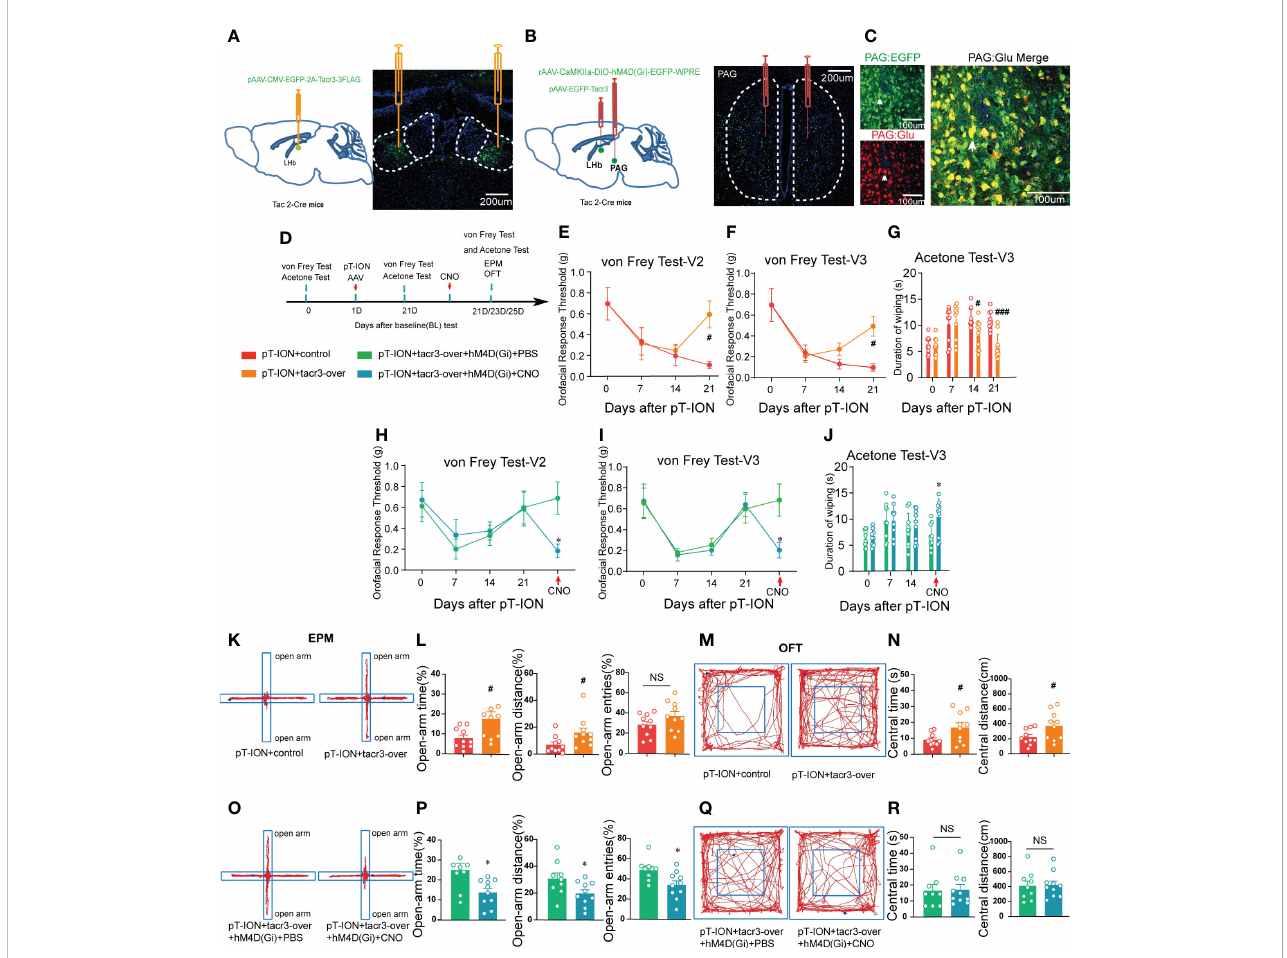
FIGURE 10 Inhibition of the release of NKB in the fPAG reversed the alleviating effect of Tacr3 overexpression in the LHb on pT-ION-induced orofacial allodynia and pain-associated anxiety-like behaviors. (A) Schematic (left) and representative image (right) of the injection of pAAV-CMV-EGFP-2A-Tacr3-3FLAG into the LHb of Tac2-Cre mice. (B) Schematic of the injection of pAAV-CMV-EGFP-2A-Tacr3-3FLAG into the LHb and injection of rAAV-CaMKIIa-DIO-hM4D (Gi)-EGFP-WPRE-hGH into the fPAG of Tac2-Cre mice (left). Typical image of rAAV-CaMKIIa-DIO-hM4D(Gi)-EGFP-WPRE-hGH injection into the fPAG of Tac2-Cre mice (right). Green, EGFP; Blue, DAPI. (C) Images showing that GFP-labeled neurons within the fPAG co-localized with glutamate. (D) The time schedule of behavioral testing, pT-ION operation, virus injection, and CNO administration. (E-G) pT-ION – induced V2 allodynia (E) , V3 allodynia (F) , and V3 cold allodynia (G) were improved by bilateral pAAV-EGFP-Tacr3 injection into the LHb (#p < 0.05, ###p < 0.001 vs. the pT-ION+vehicle group, n = 10 mice per group). However, the improvements in primary mechanical allodynia (H) , secondary mechanical allodynia (I) , and secondary cold allodynia (J) were reversed by bilateral rAAV-CaMKIIa-DIO-hM4D(Gi)-EGFP injection into the fPAG after CNO administration. (*p < 0.05 vs. the pT-ION+tacr3-over +hM4D(Gi)+PBS group, n = 10 mice per group). (K, O) Typical trajectories in the EPM. (L) The percentages of open-arm time and distance after pT-ION were increased by bilateral pAAV-EGFP-Tacr3 injection into the LHb, while the percentage of open-arm entries remained unchanged (#p < 0.05 vs. the pT-ION+vehicle group, n = 10 mice per group). (P) The increased percentages of open-arm time, distance, and entries was reversed by bilateral rAAV- CaMKIIa-DIO-hM4D(Gi)-EGFP injection into the fPAG after CNO administration (*p < 0.05 vs. the pT-ION+tacr3-over+hM4D(Gi)+PBS group, n = 10 mice per group). (M, Q) Typical trajectories in the OFT. (N) The central distance and central time were increased by bilateral pAAV-EGFP-Tacr3 injection into the LHb (#p < 0.05 vs. the pT-ION+vehicle group, n = 10 mice per group). (R) The central distance and central time remained unchanged after bilateral rAAV-CaMKIIa-DIO-hM4D(Gi)-EGFP injection into the fPAG after CNO administration (n = 10 mice per